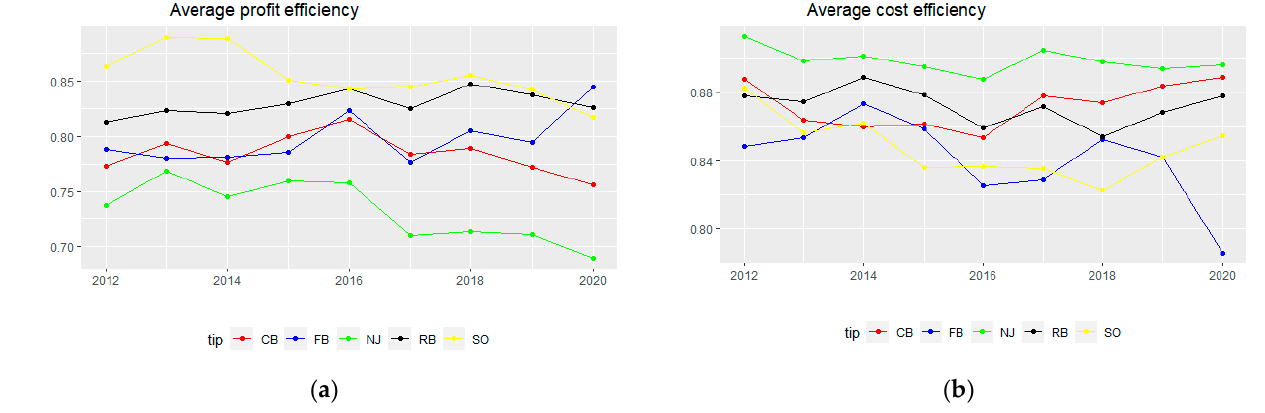
Figure 3. ( a ) Average pro fi t e ffi ciency by bank type; ( b ) average cost e ffi ciency by bank type.